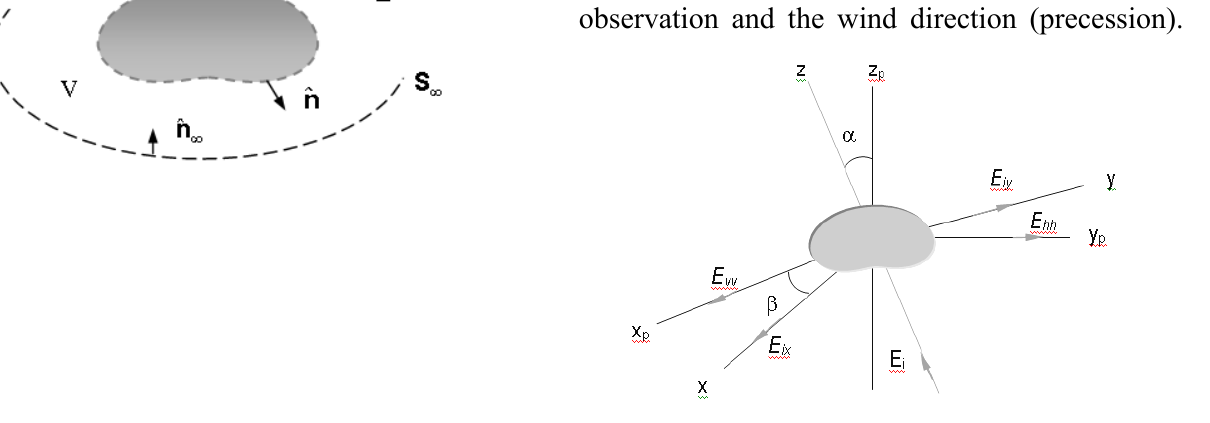
incident field propagates along ˆ z , drop axis ˆ z along , α : drop canting angle (nutation), and β : p angle between the azimuth of the direction of observation and the wind direction